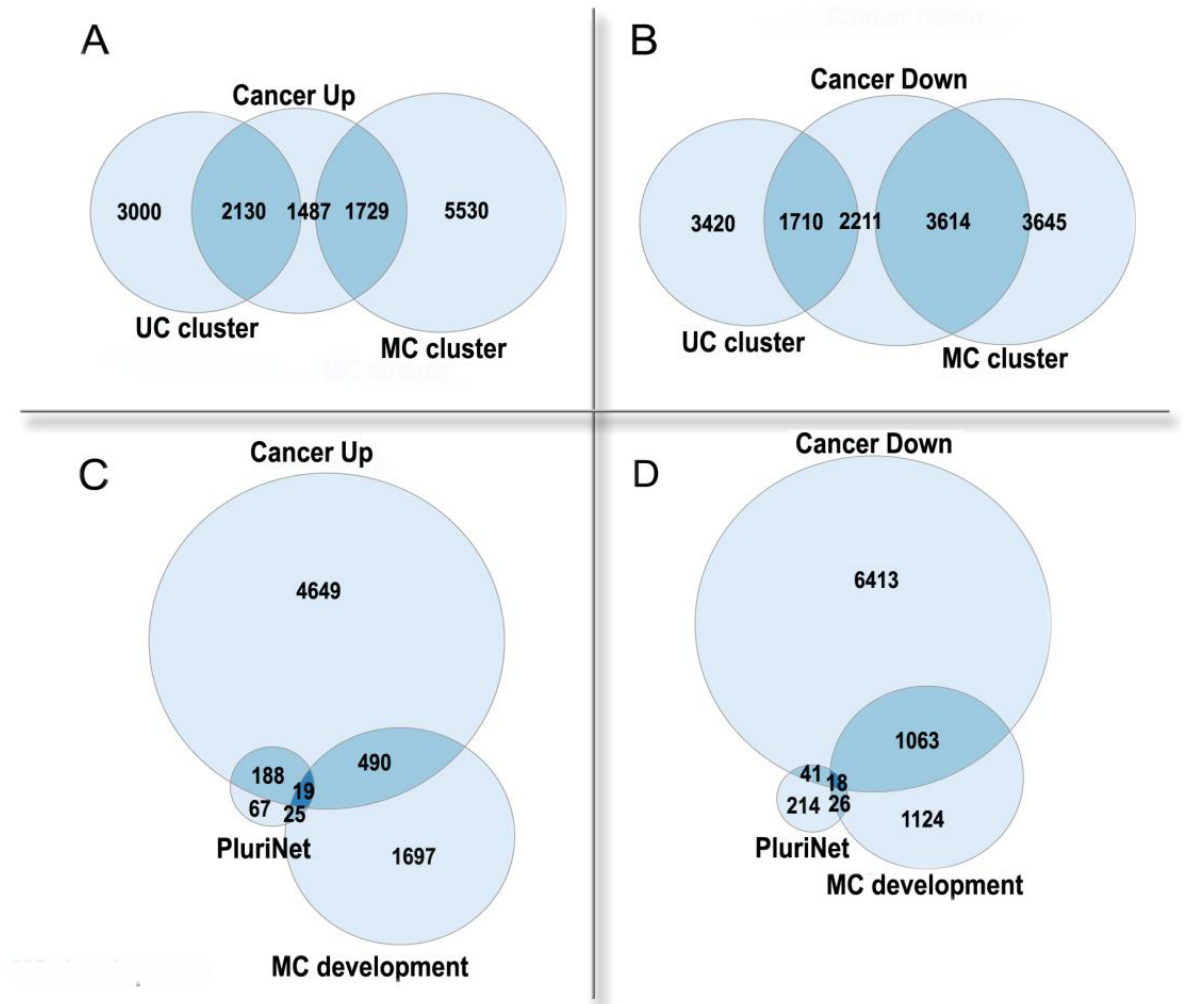
Figure 4. The enrichment of human genes, which are up- or down-regulated in polyploid cancer cells as compared with diploid cells of the same cancer, in functional gene groups. ( A , B )—unicellu- lar (UC) and multicellular (MC) giant clusters of interactome.UC cluster: enrichment p < 10 −157 in Up,